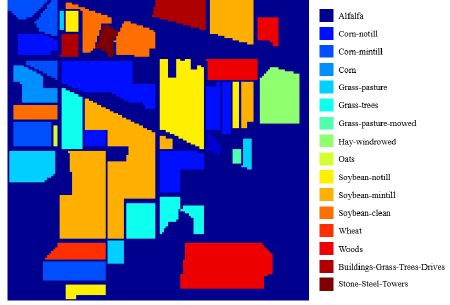
Figure 6. The groundtruth of Indian Pines. Table 1. Labeled samples in Indian Pines